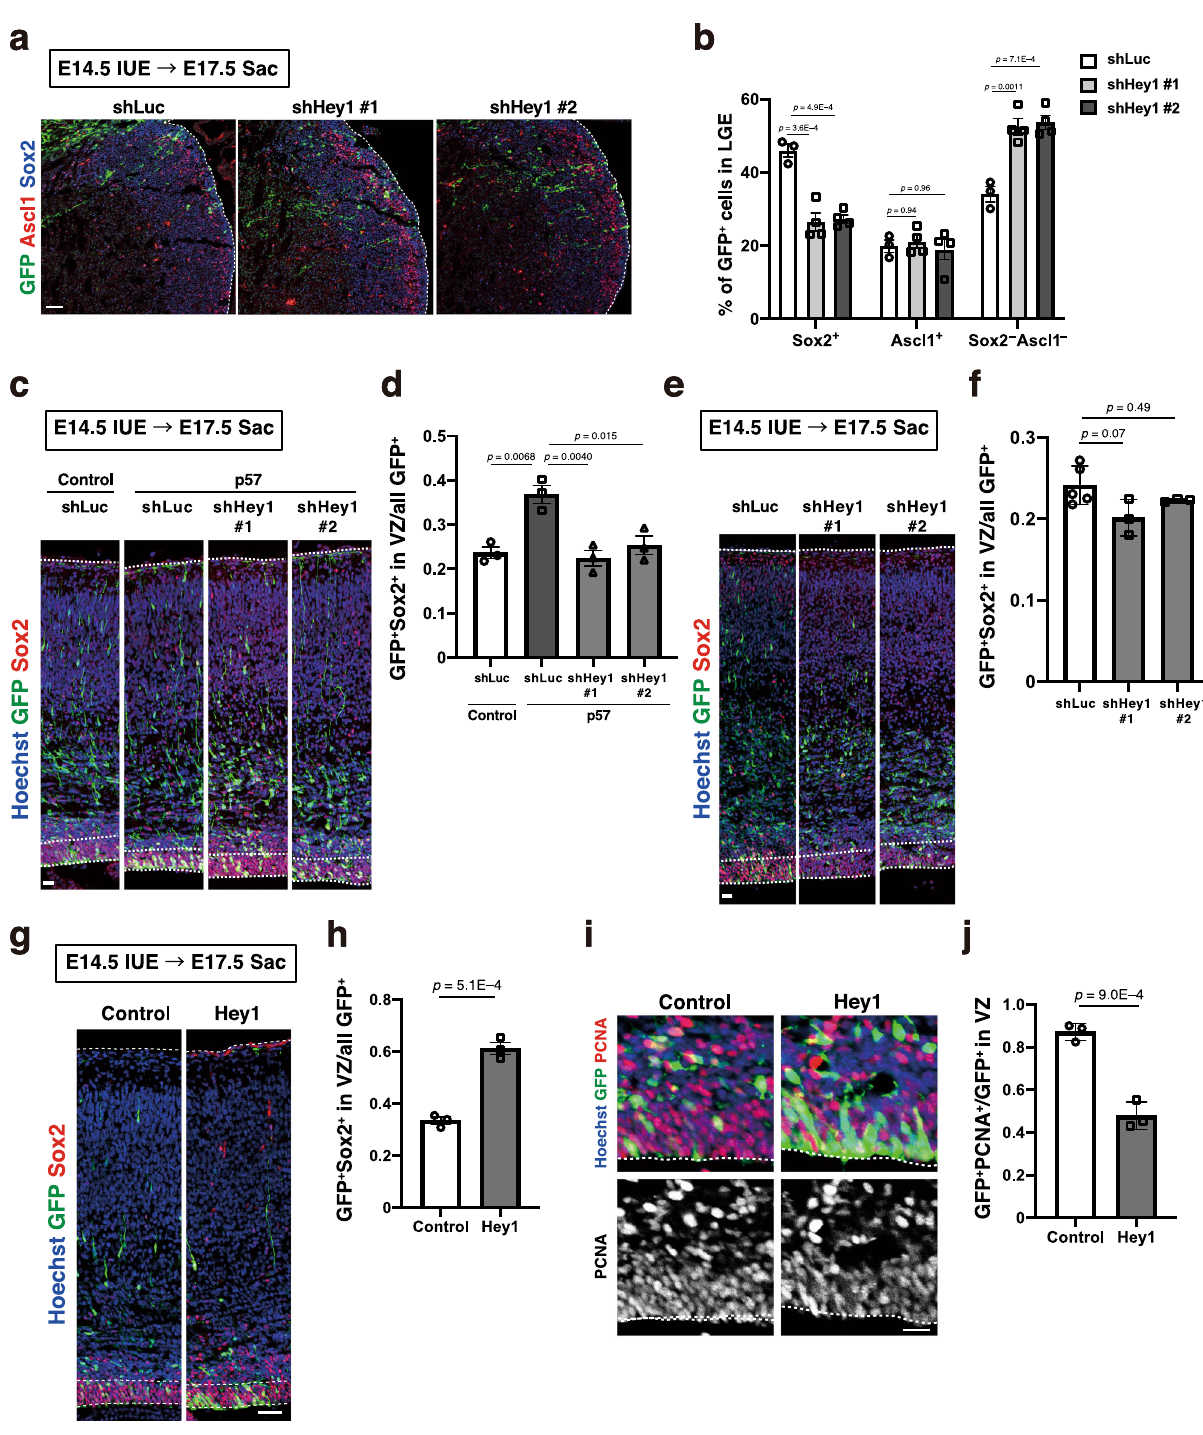
or maintenance of this slowly dividing embryonic NPC popula- lateral wall at the level of the rostral-caudal axis, + 0.9 to + 0.1 mm relative to the bregma) where around 60% of NSCs de fi ned as GFAP + Vcam1 + cells expressed Hey1 at high levels at P15 (Supplementary Fig. 6b, c). The number of NSCs — as de fi